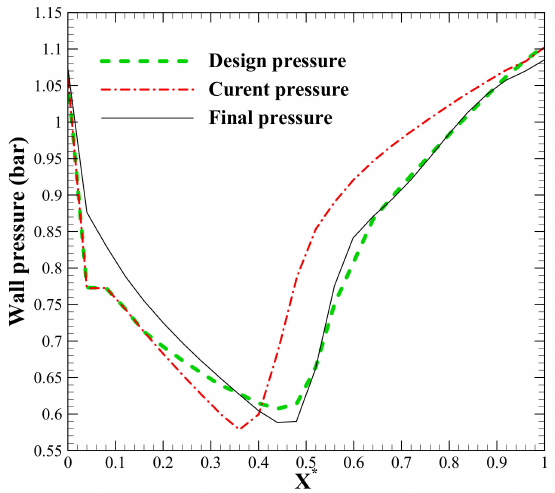
Figure 16. Current, design, and final pressure distributions versus non-dimensionalized X*— coordinate, for the second design of the suction side of a transonic blade by UESA with the spine constraint and E distribution applied.